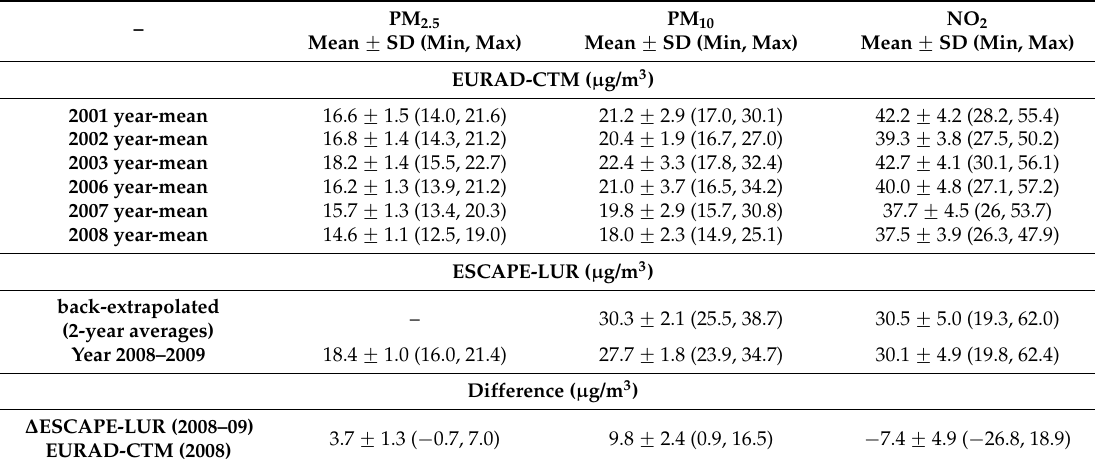
Table 2. Description of residence-based air pollutant exposure estimates PM 2.5 , PM 10 , and NO 2 from EURAD-CTM and ESCAPE-LUR for 4809 residences within the HNR study